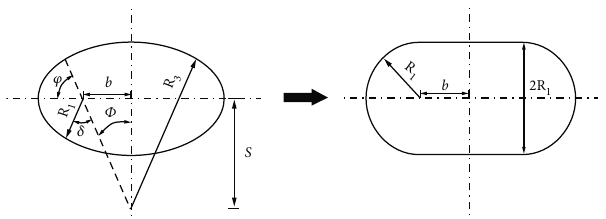
Figure 10: Cross-section of quasirectangular shield tunnel and equivalent Table 1: The geometric dimensions of quasirectangular shield tunnel.